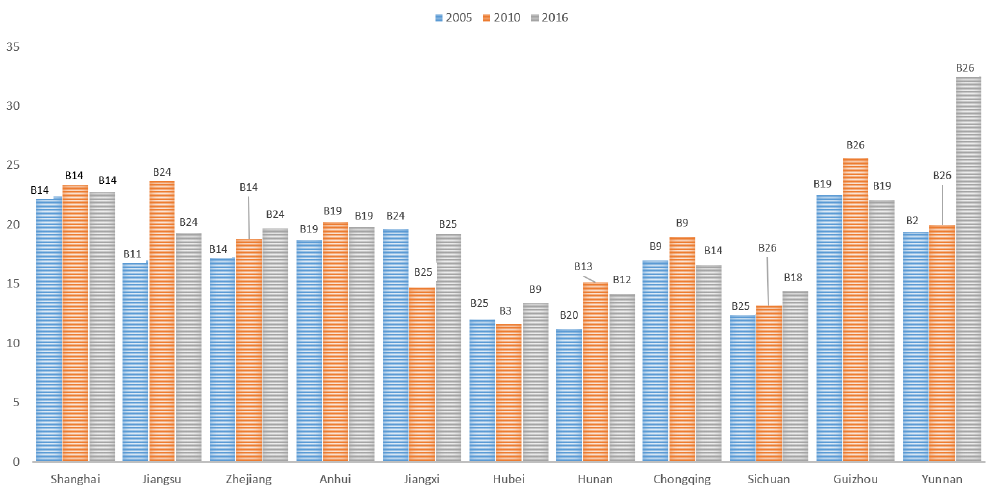
Figure 6. CERC index barrier factors and their obstacles (%).